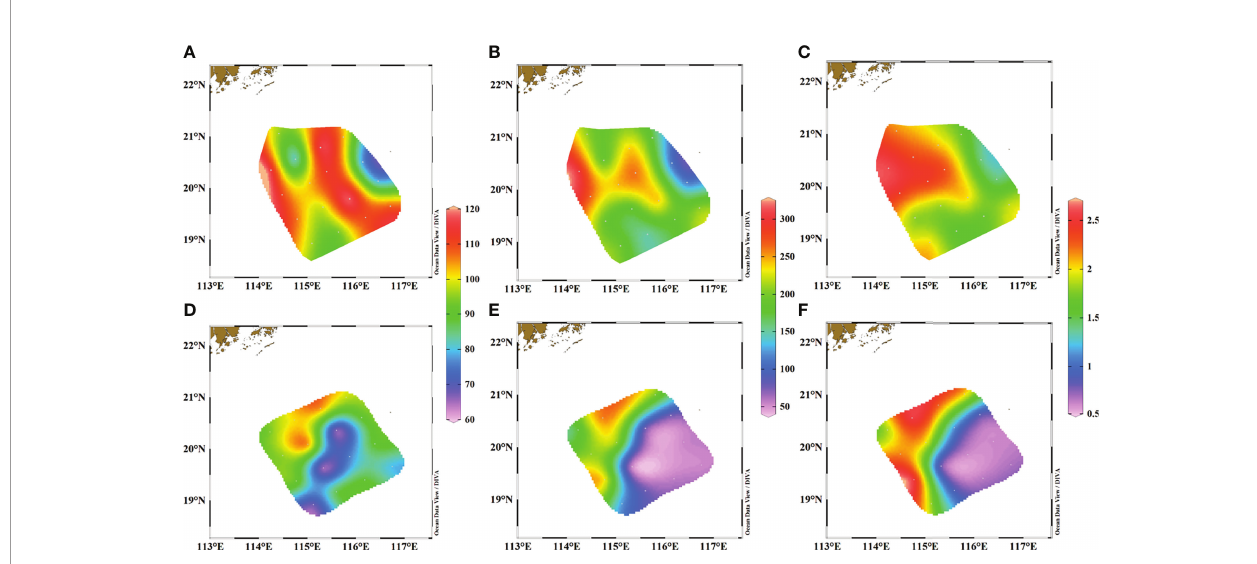
FIGURE 3 | Distributions of surface Ra activities (dpm/m 3 ) and the ratios in our study. (A) 226 Ra in June 2015, (B) 228 Ra in June 2015, (C) 228 Ra/ 226 Ra ratios in June 2015, (D) 226 Ra in March 2017, (E) 228 Ra in March 2017, and (F) 228 Ra/ 226 Ra ratios in March 2017.